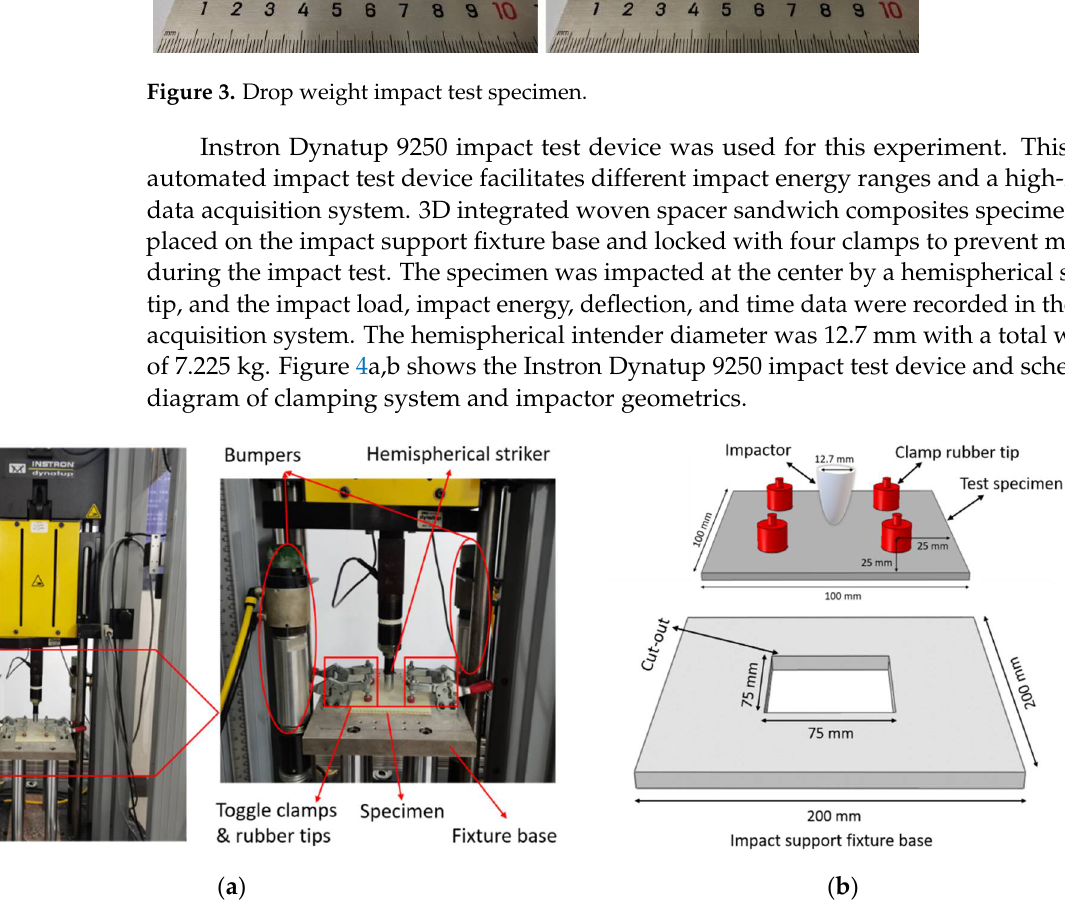
Figure 4. ( a ) Instron Dynatup 9250 impact test device. ( b ) Schematic diagram of clamping system and impactor geometrics.